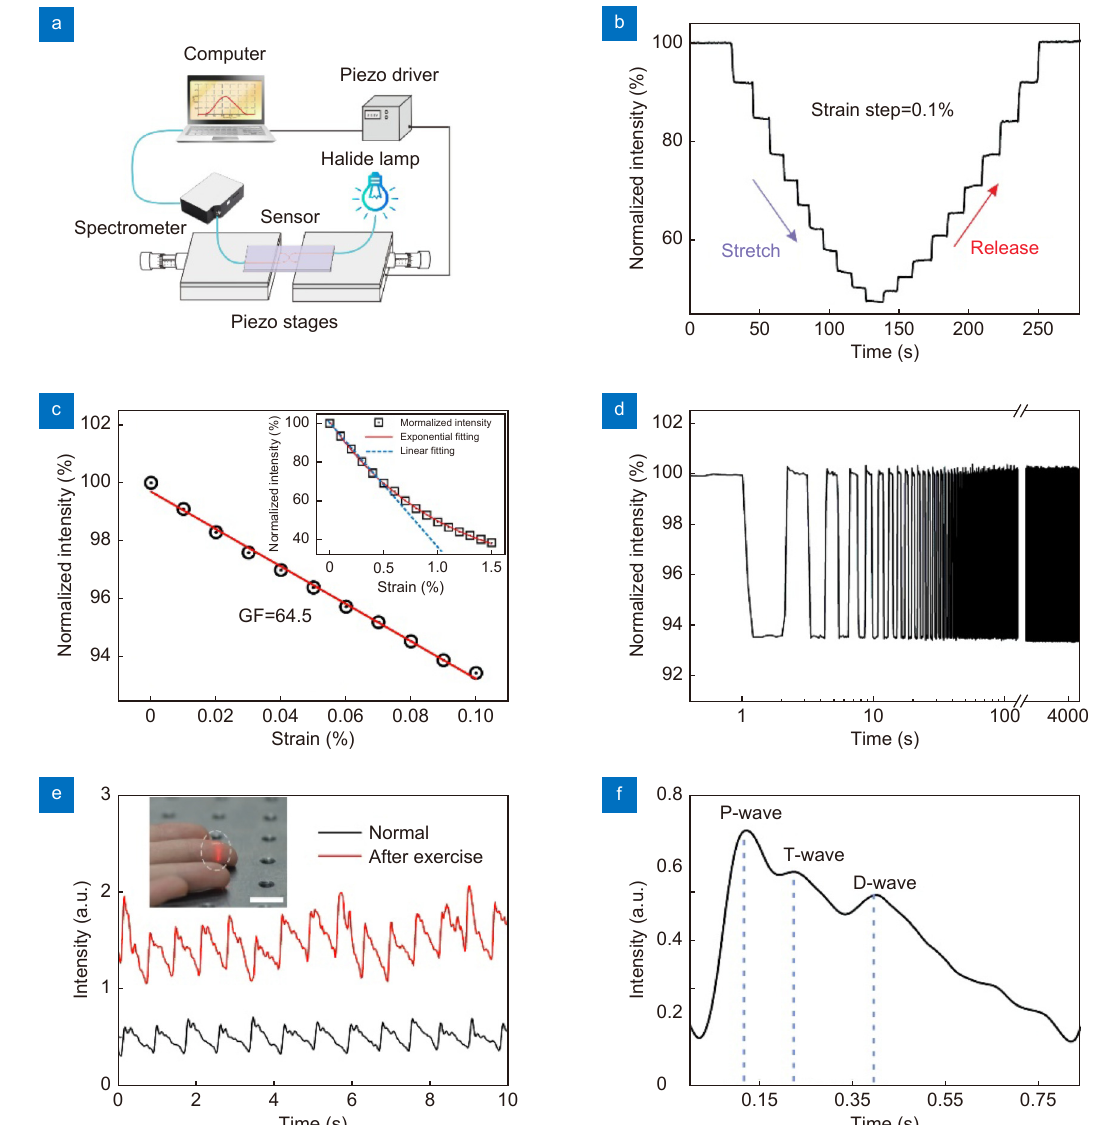
Fig. 2 | The strain response of the sensor. ( a ) Schematic diagram of the experimental setup for strain sensing. ( b ) The response of the sensor in a stretch and release cycle reveals good reversibility of the device. ( c ) Linear fitting of experimental data result in a GF of 64.5 within the strain range of 0.1%. Such linear relation can be extended to a strain range up to 0.5%, shown as the blue dotted-line in the inset, while the general re- lation between the normalized intensity and strain can be fitted by an exponential function in the strain range of 0–1.5%. ( d ) The durability test for 2000 cycles under 0.1% strain. ( e ) Measurement of the real-time fingertip pulse wave under normal conditions (72 beats per minute) and after ex- ercise (85 beats per minute). The inset shows a photo of the sensor attached to the fingertip to test the pulse of the fingertip, and the scale bar is 1 cm. ( f ) Typical measured pulse waveform with distinguishable P-wave, T-wave and D-wave